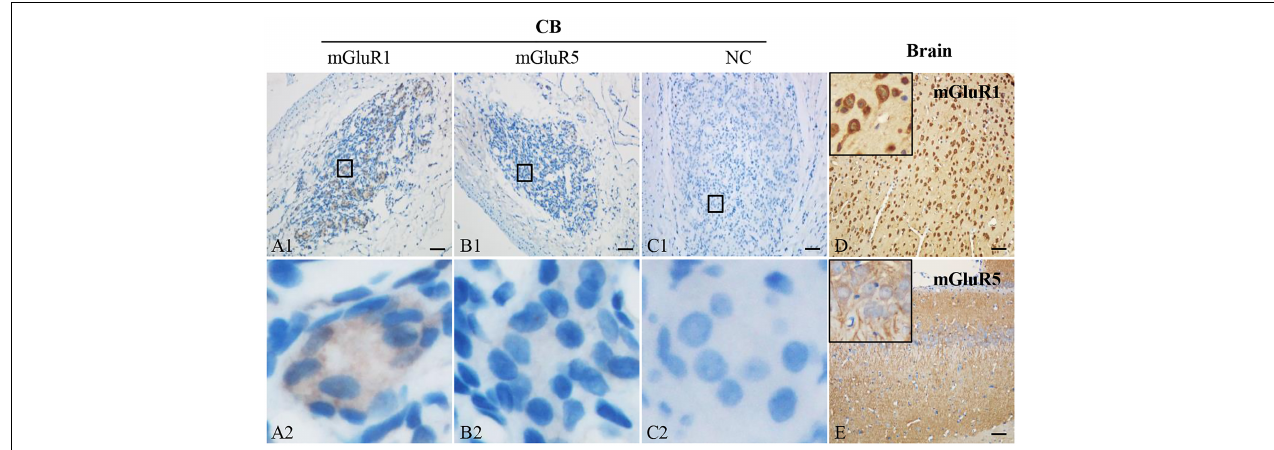
FIGURE 2 | Immunohistochemical staining of mGluR1 and mGluR5 in rat CB. Representative images of rat CB and brain sections were immunostained with mGluR1 and mGluR5. Panels (C1,C2) are negative staining controls obtained by omitting the primary antibody. mGluR1 (D) or mGluR5 (E) staining of rat brain sections were used as positive controls. Panels (A2–C2) are higher-magnification images of framed areas in (A1–C1) , respectively. The brown staining represents the mGluR1 or mGluR5, while the blue staining represents hematoxylin-stained cell nuclei. mGluR, glutamate metabotropic receptor; NC, negative control. Scale bar, 50 µ m for all